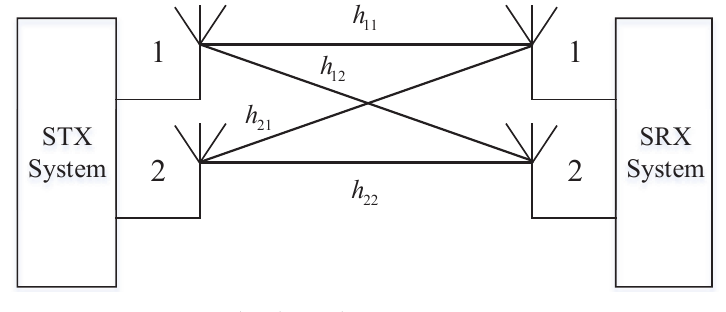
Figure 16. Dual-polarized 2 × 2 MIMO antenna